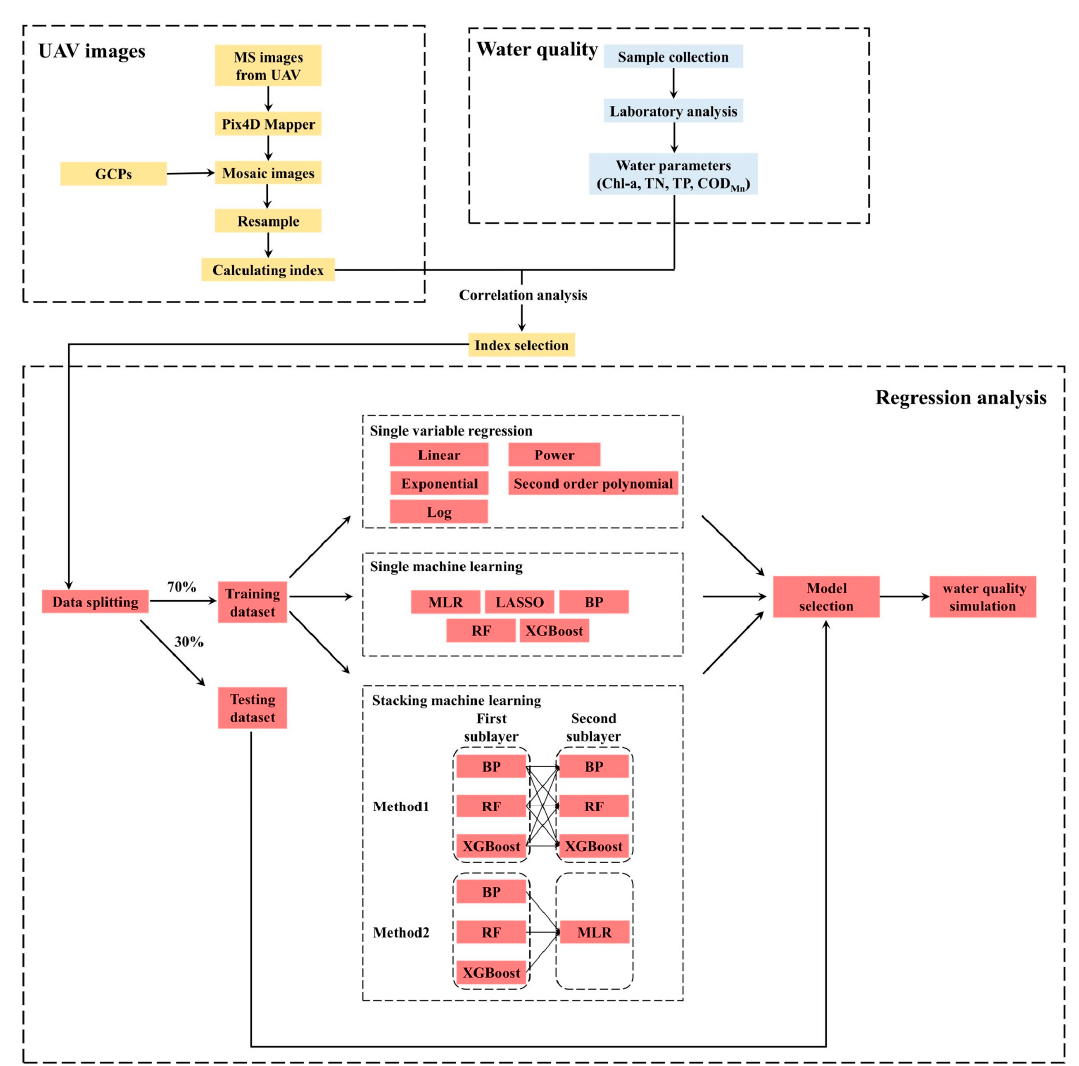
Figure 4. Workflow chart of the data processing procedure.